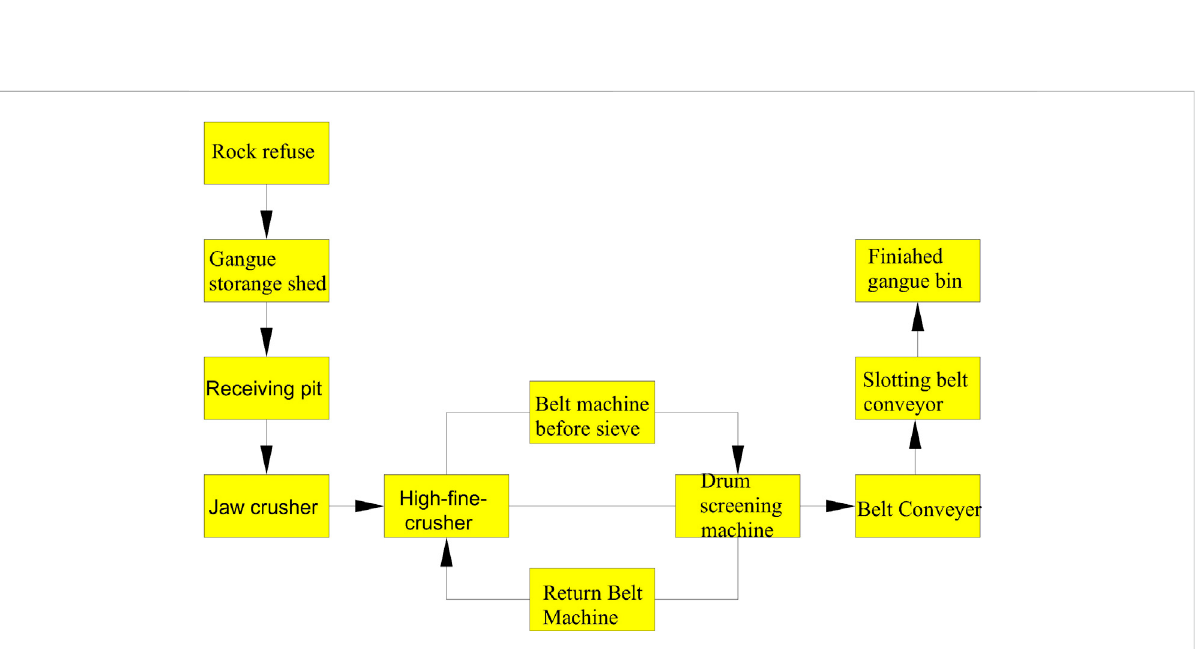
FIGURE 7 Process fl ow diagram of the gangue crushing